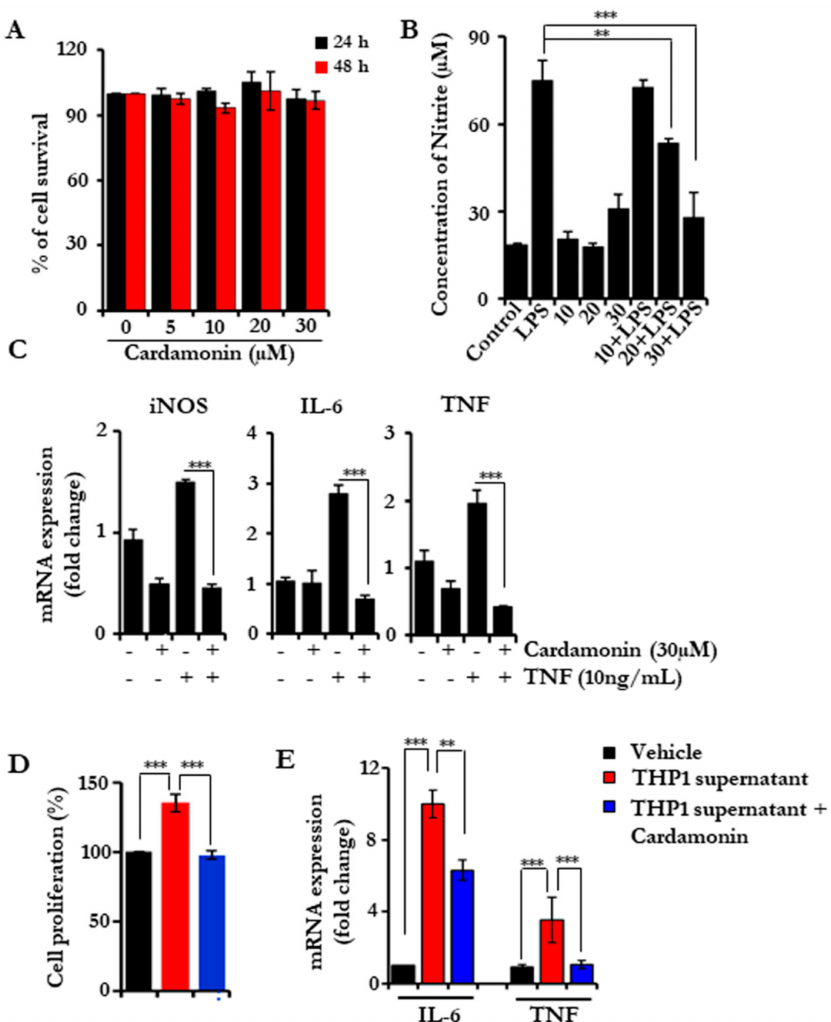
Figure 1. Cardamonin blocks the NO production in RAW 264.7 cells and reduces the inflamma- tory cytokine burden. ( A ) Cell proliferation assay in RAW 264.7 cells showing the cytotoxicity of cardamonin in a dose-dependent manner after 24 and 48 h of treatment. ( B ) Assessing the nitrous oxide levels released after LPS stimulation using Griess reagent after pretreating with cardamonin. ( C ) Quantitative PCR analysis for iNOS, IL6 and TNF- α levels in RAW 264.7 cells after treatment with cardamonin and TNF induction as indicated. GAPDH was used as the house-keeping gene. ( D , E ) HCT116 cells were cultured and THP-1 conditioned medium collected from THP-1 culture treated with either vehicle of cardamonin (20 µ M; 24 h) was added. The cell proliferation was assessed after 24 h using an MTT assay ( D ); the RNA was isolated after 3 h and gene expression was analyzed using RT-PCR ( E ). Statistical significance was determined by Student’s t -test, ** p < 0.005, *** p <